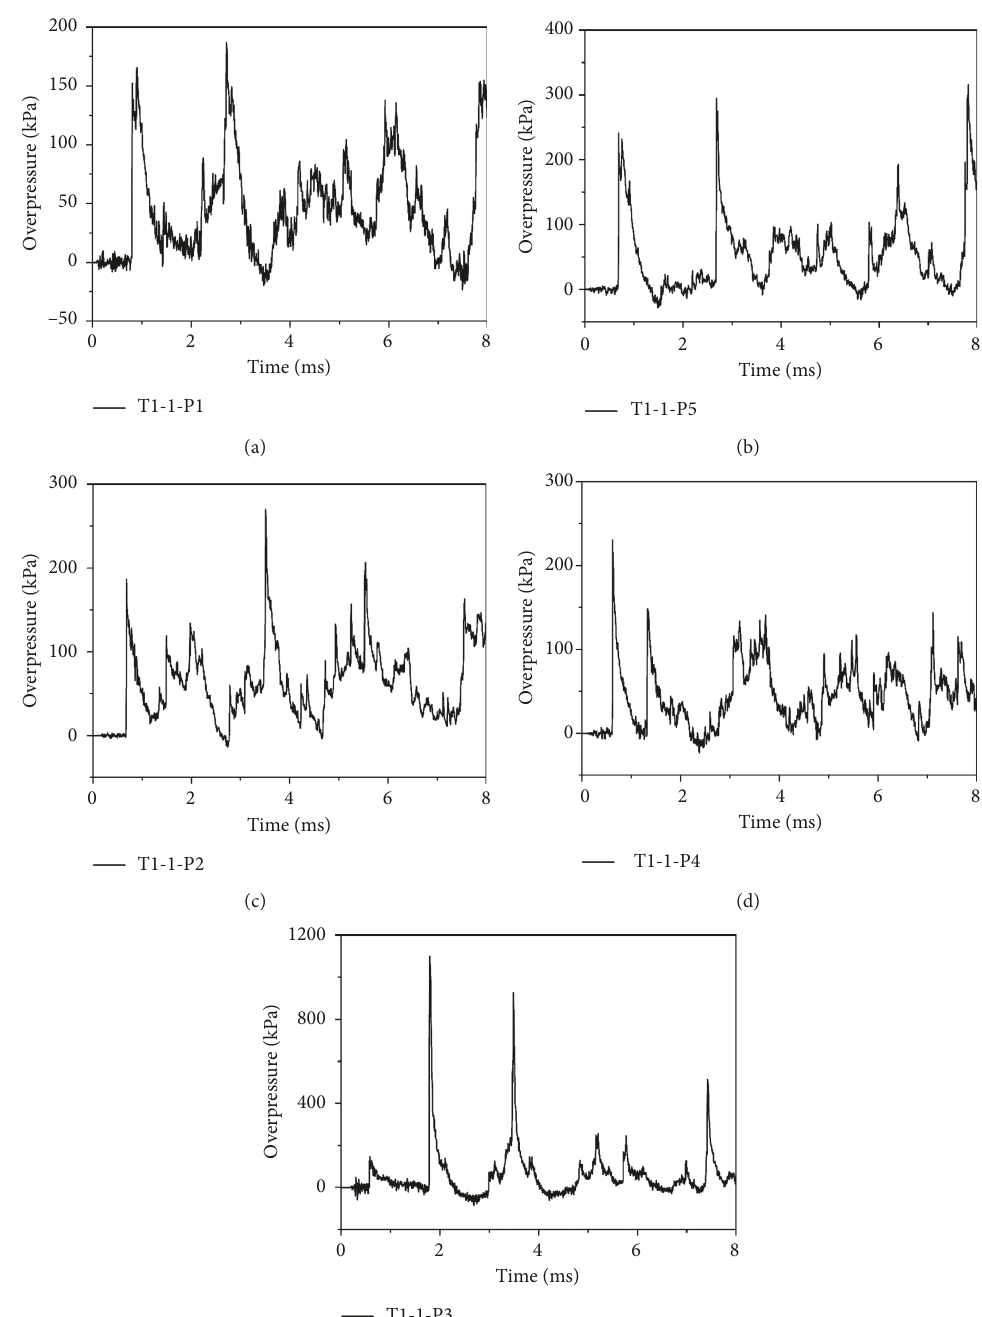
Figure 6: Experiment data from scenario T1 (8g). (a) Test data from P1. (b) Test data from P5. (c) Test data from P2. (d) Test data from P4. (e) Test data from